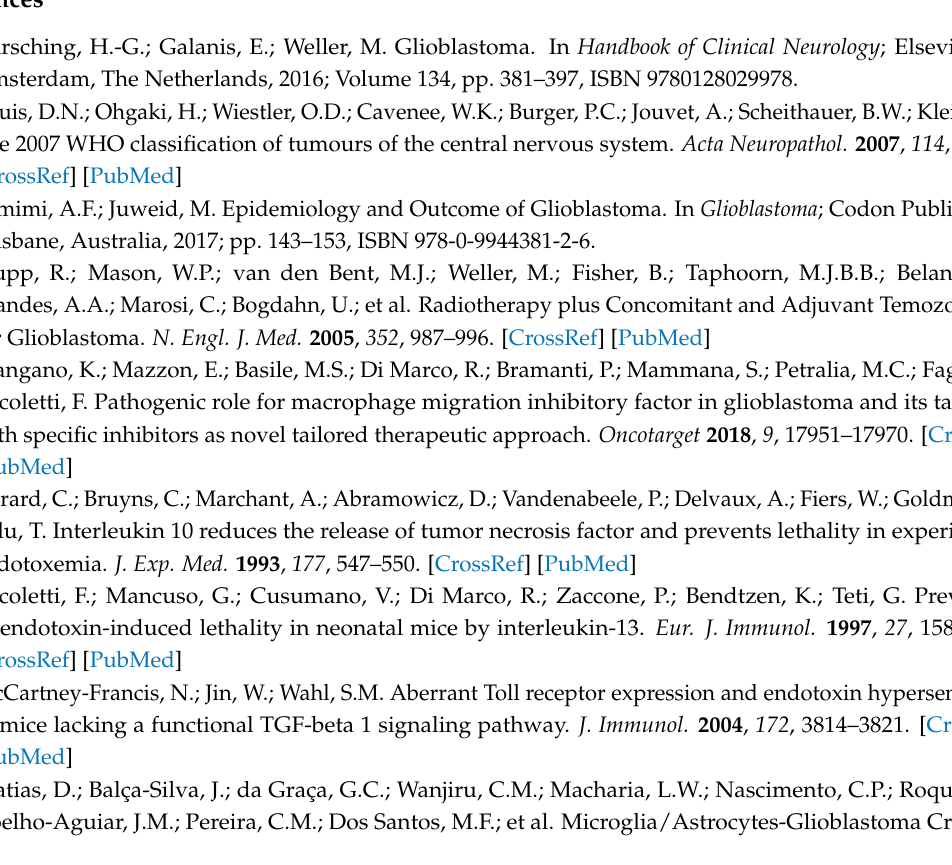
Supplementary Materials: Figure S1: Cytoprotective role of autophagy in Lopi-NO treated LN-229 cells. Cells were treated with IC 50 value of Lopi-NO in the presence of autophagy inhibitor 3-MA (1 mM) or chloroquine (20 µ M) for 48 h and cellular viability by MTT test was estimated. * p < 0.05 compared to untreated cultures, Figure S2: Interplay between Lopi-NO and Cisplatin on U-251 cells. Cells were exposed to Cisplatin in the presence of IC 50 value of Lopi-NO and cellular viability was measured by CV